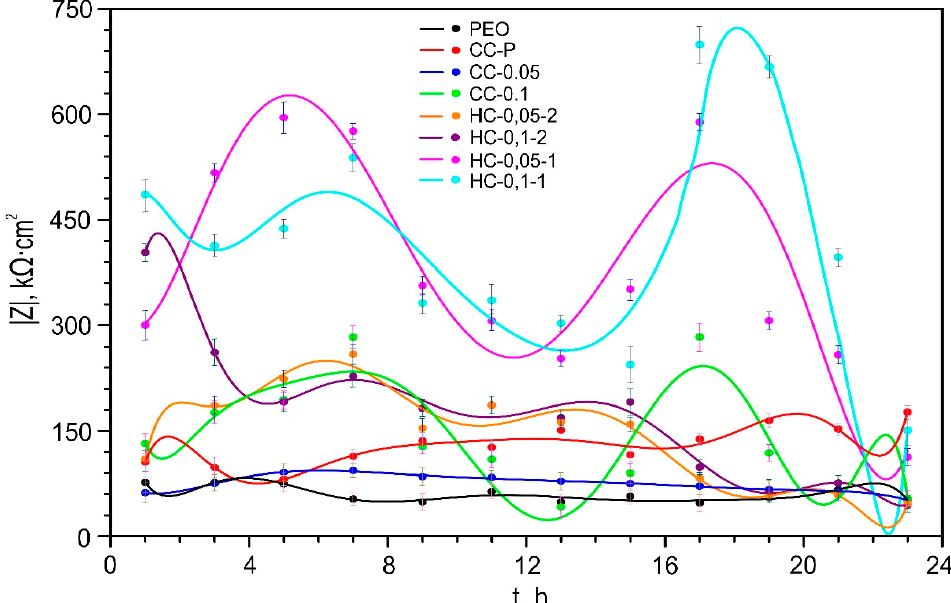
Figure 7. Dynamics of change in magnitude of impedance modulus, measured at a low frequency (|Z| f =0.1Hz ), over the exposure time of samples with different types of Btr-containing coatings in sodium chloride solution. The errors for the measured parameters did not exceed 10%. Table 3. Electrochemical parameters obtained by analyzing the polarization curves and impedance spectra before and after samples’ exposure to 0.9 wt.% NaCl solution for 24 h.